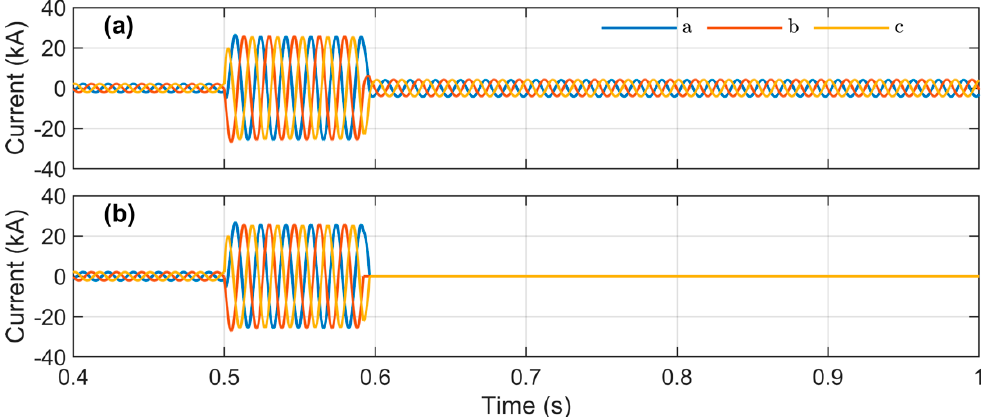
Figure 12. Currents in HTS cables in case DCRs operate normally: ( a ) HTS 1 ; ( b ) HTS 2 .